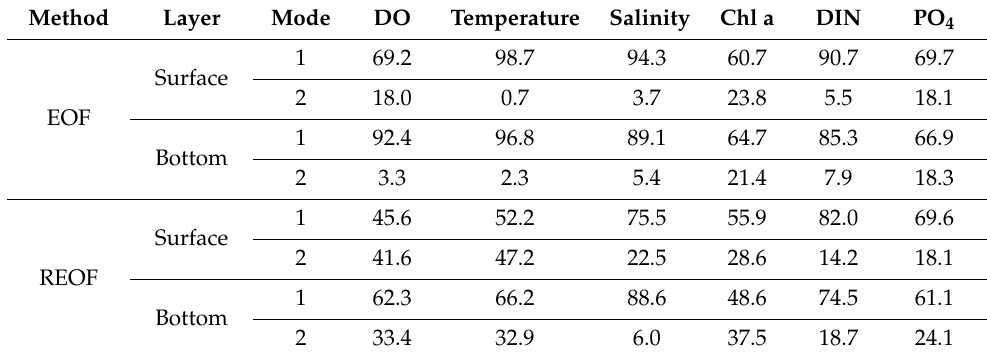
Table 1. Variance contributions (%) of the EOF and REOF of environmental factors.